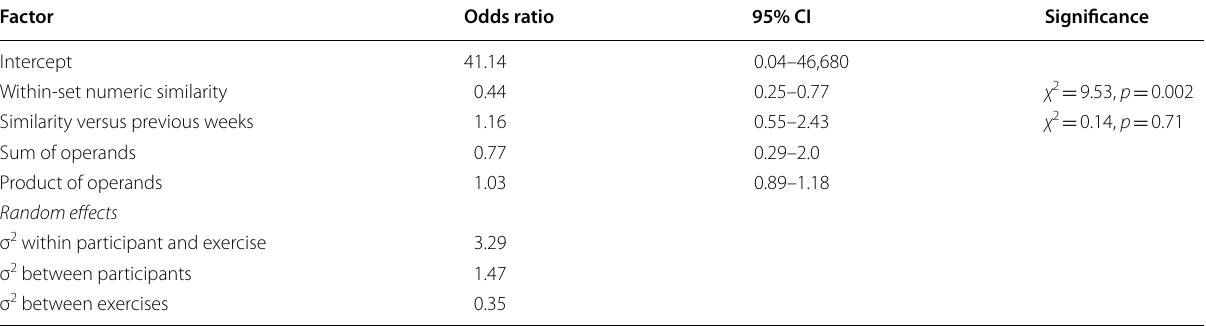
A significant effect was found only for the within‑set